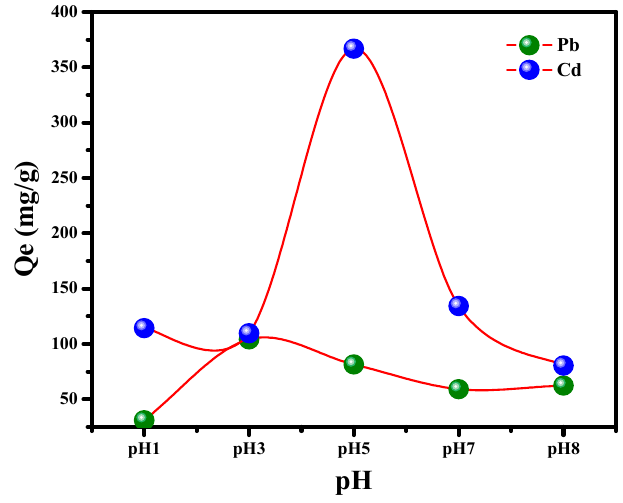
Figure 6. Effect of pH on the removal of Pb ++ /Cd ++ by MGCN nanosorbent.